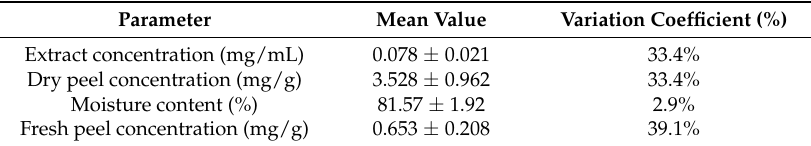
Table 1. Total hesperidin content in Mexican lime peel.